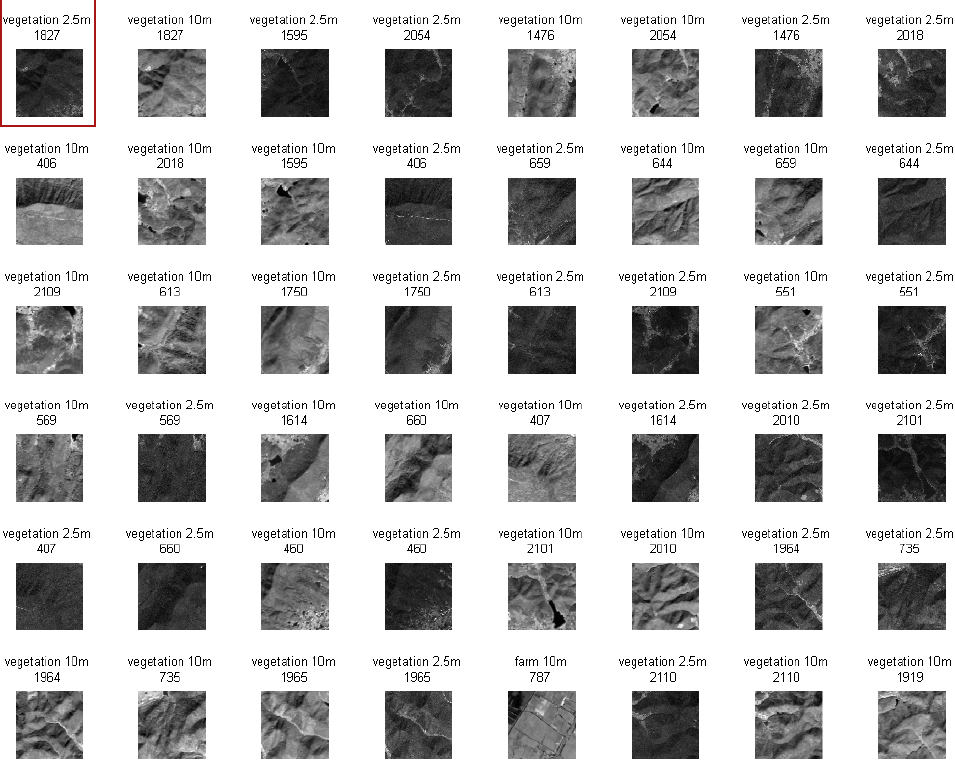
Figure 5: Retrieval results for an image patch of the Vegetation